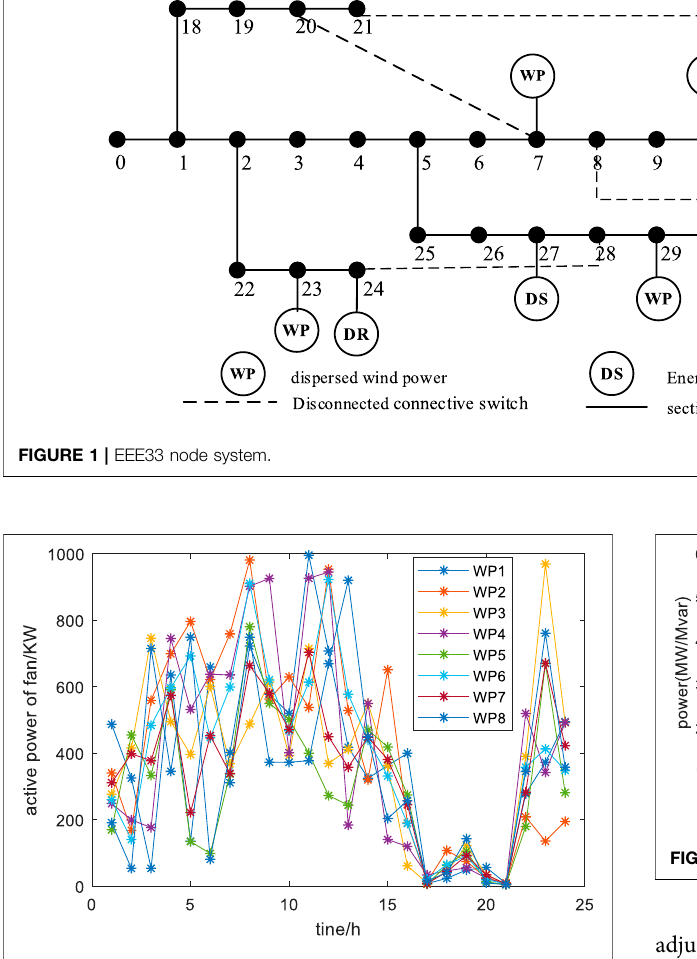
FIGURE 2 | Pre-dispatch output of each wind turbine.